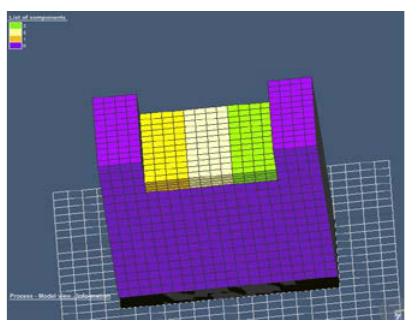
Fig. 2. Three-dimensional finite element